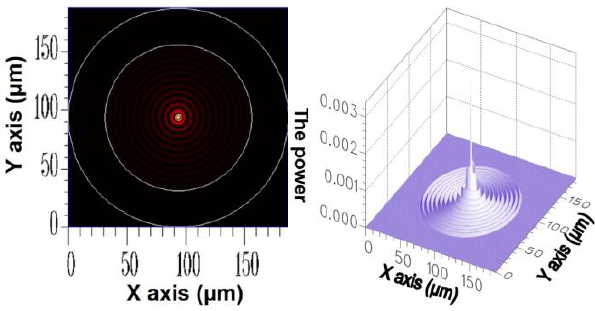
Figure 21. Plot of the power propagation in the x - z plane for the total coupling from HE to a counterpropagating cladding mode ( ν = 21).